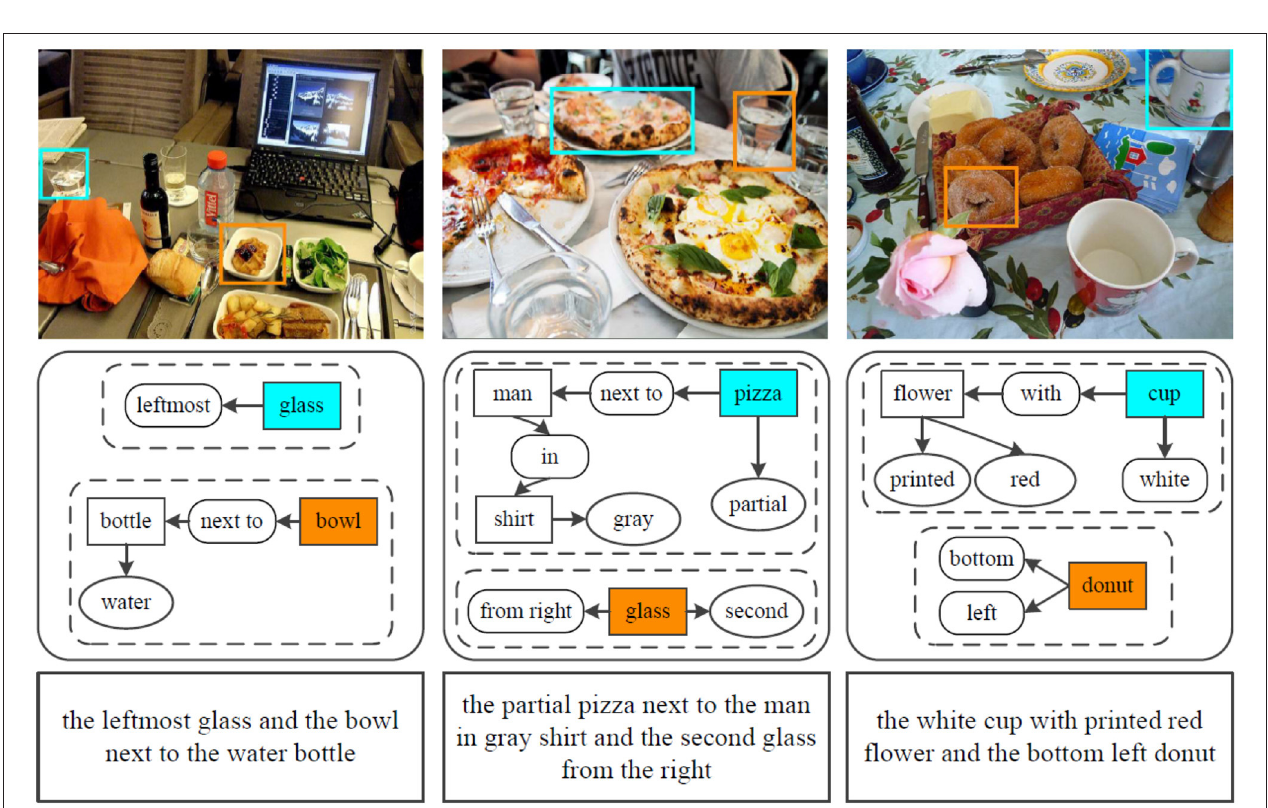
FIGURE 5 | Example results of interactive natural language grounding on MSCOCO images. The input natural language instructions are listed in the third row with rectangle, the scene graph parsing results are shown in the second row with rounded rectangle.